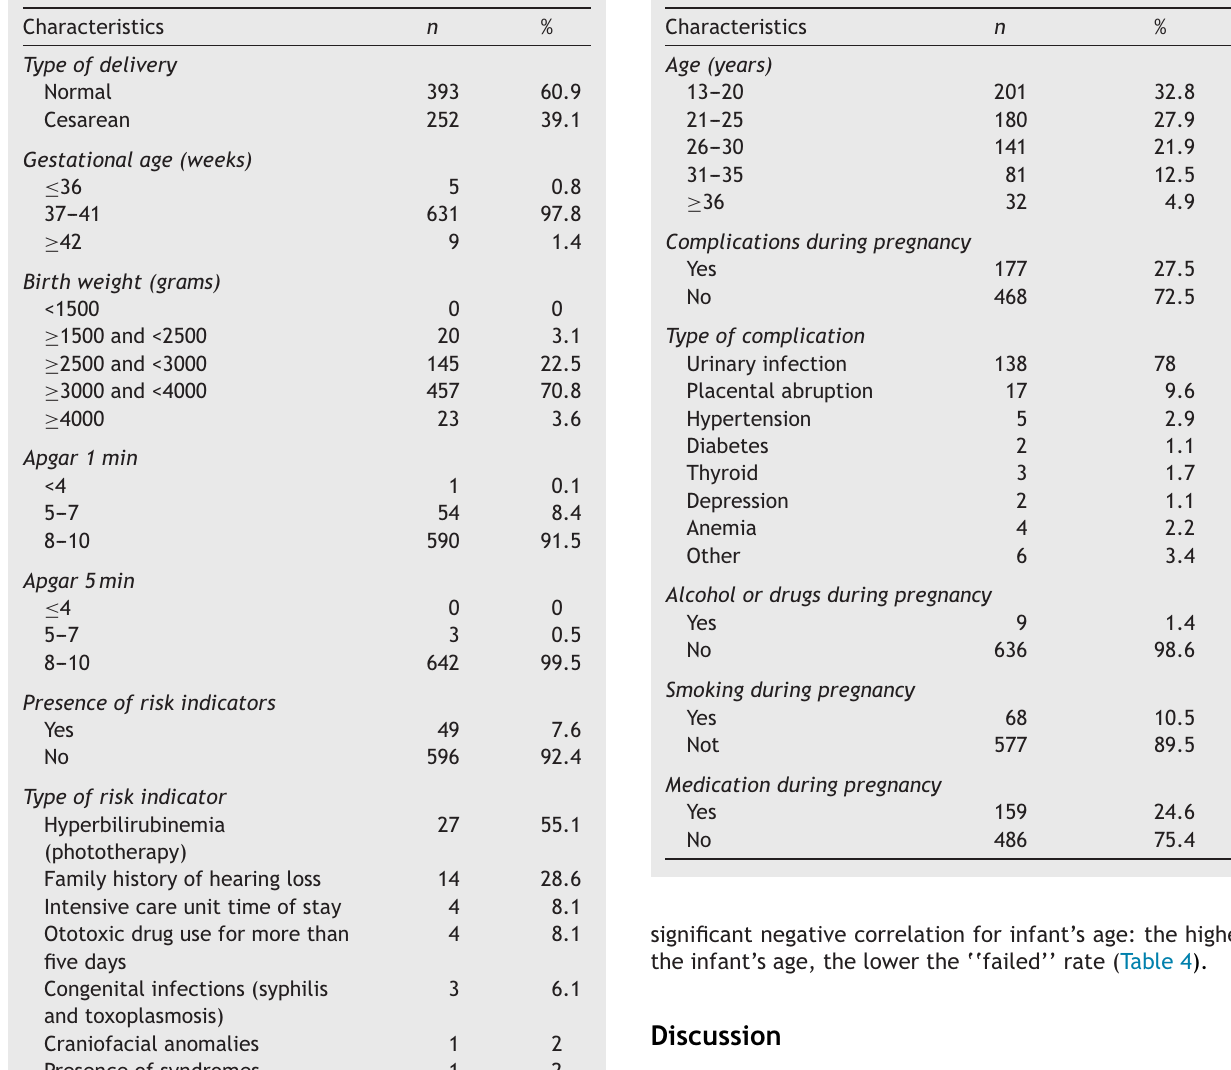
Perinatal characteristics of babies screened in the program.